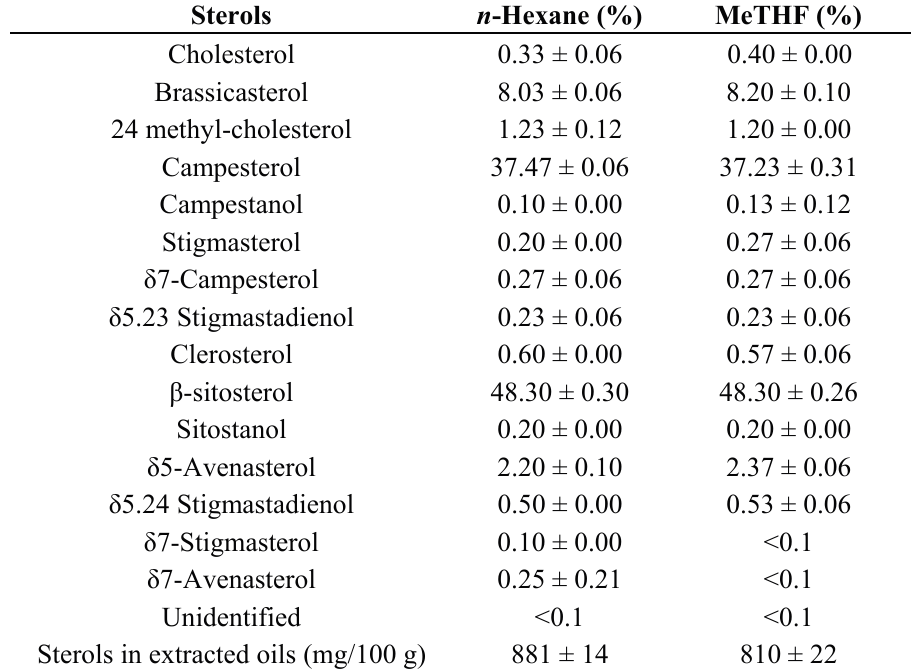
Figure 3. HP-TLC plate: lipid classes in rapeseed oil extracted with n- hexane and MeTHF (TAG: triglyceride; FFA: free fatty acids; DAG: diglyceride; MAG: monoglyceride; PE: phosphatidylethanolamine; PC: phosphatidylcholine; LPC: lysophosphatidylcholine). Table 5. Content of sterols in extracted rapeseed oils with n -hexane and